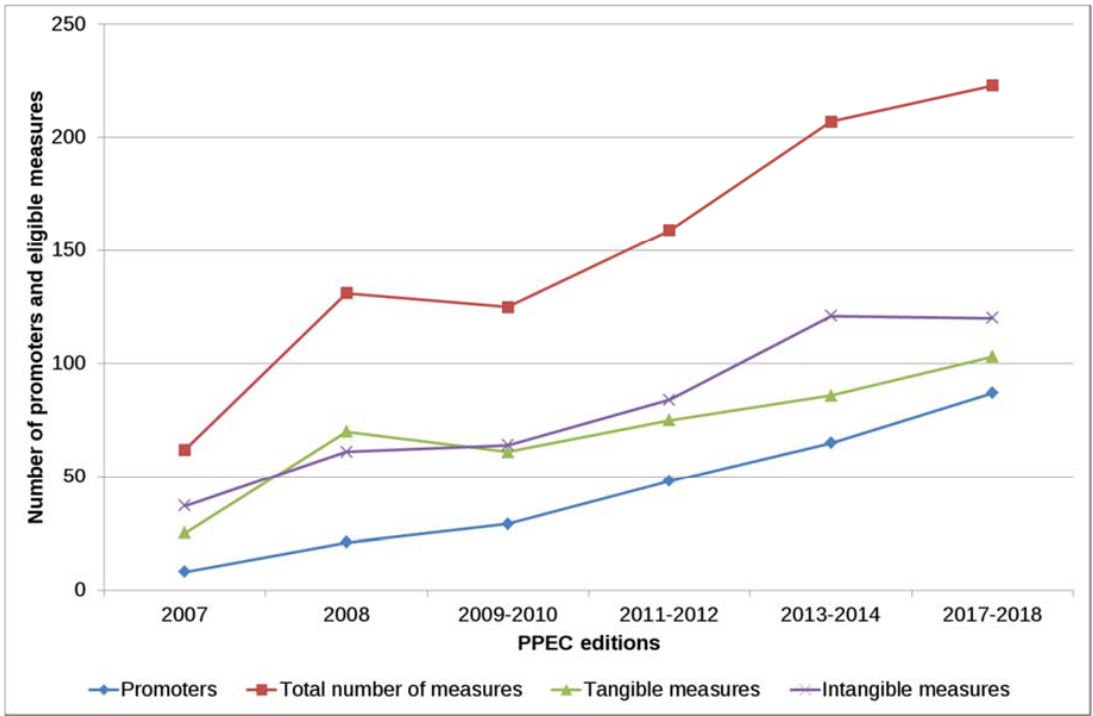
Figure 2. Evolution of the number of promoters and eligible measures in each PPEC edition [19–25].